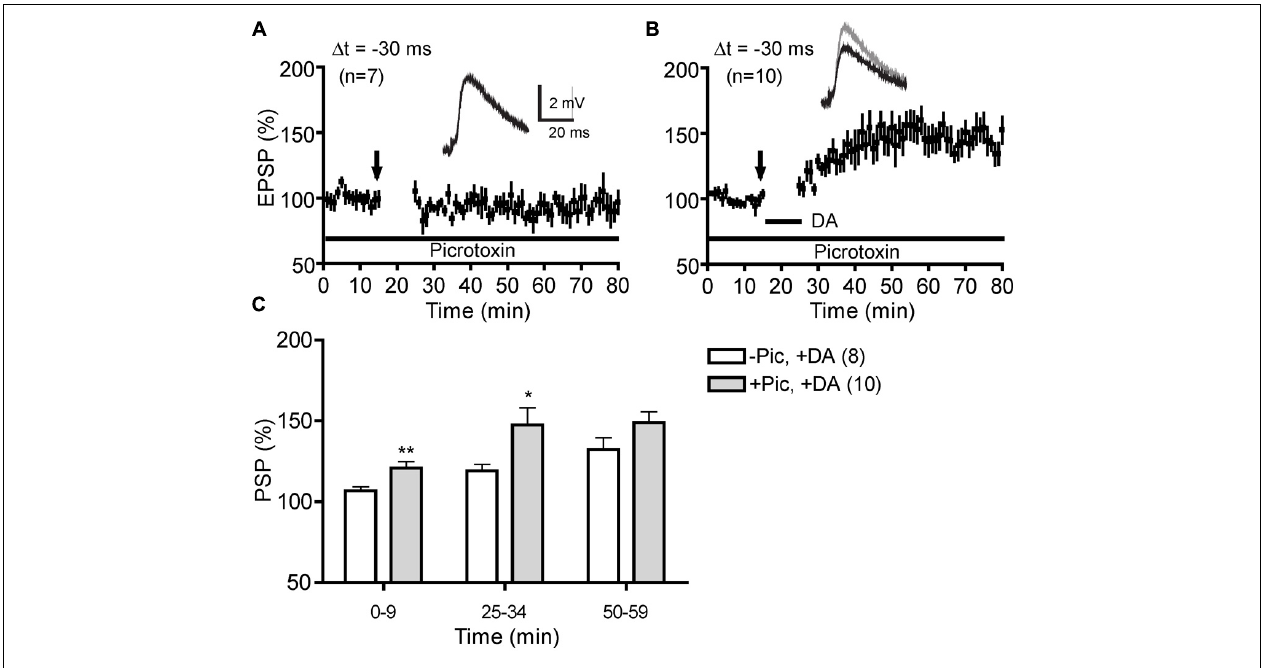
Δ t = − 30 ms in the presence of picrotoxin. (C) Comparison of DA-enabled t-LTP magnitude with and without picrotoxin at different times following post–pre pairings. * P < 0.05; ** P < 0.01. Student’s t